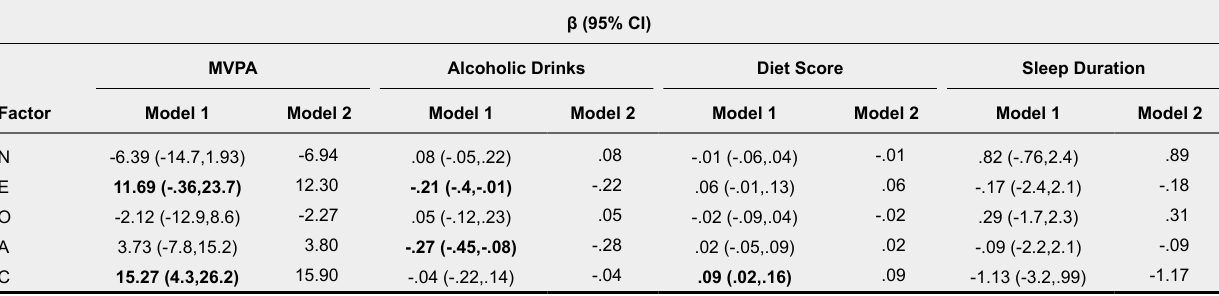
Simple Linear Regression Association Between Personality Type and Individual Health Behaviors, With Correction for Regression Dilution